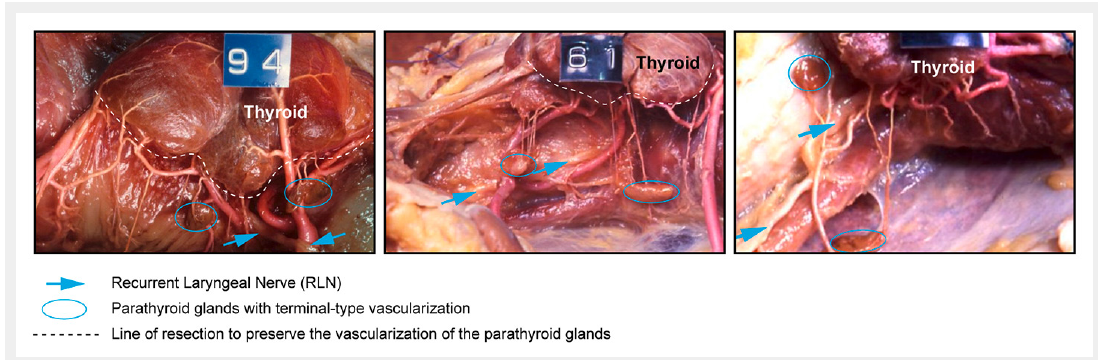
Anatomical preparations demonstrating the thyroid gland, and the parathyroid glands in different anatomic locations with their terminal-type vascularisation, and the recurrent laryngeal nerve. Adapted from Delattre JF, Variations in the parathyroid glands. Number, situation and arterial vascularisation. Anatomical study and surgical application J Chir (Paris).